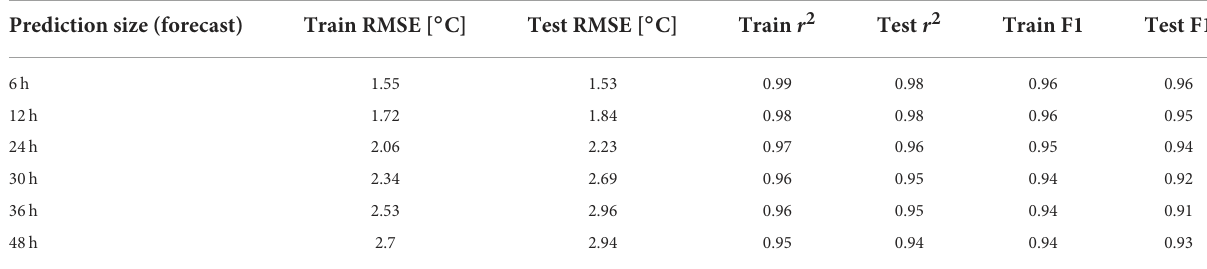
TABLE 3 Same as Table 2 but for the results of the fully connected DNN model predictions. Fully connected deep neural network model